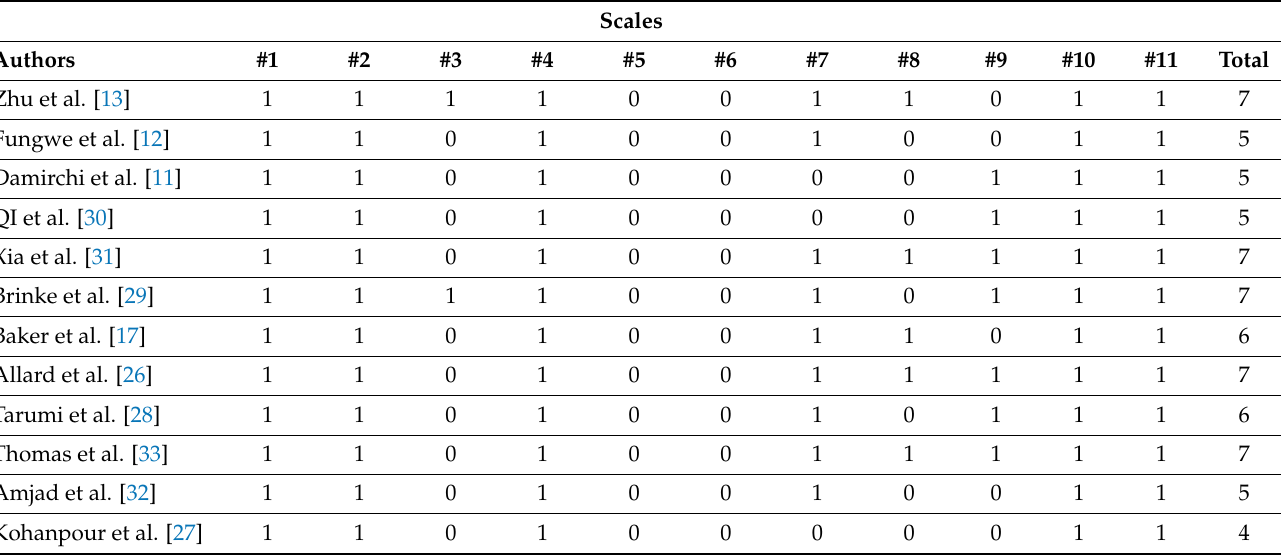
Table 5. The methodological quality of the reviewed studies using the PEDro scale.